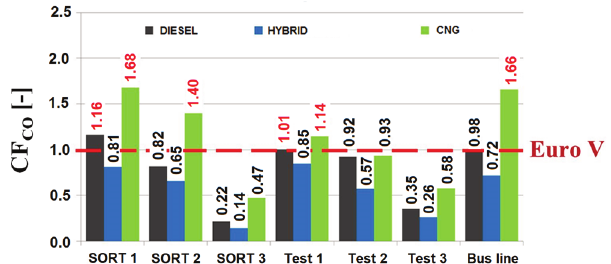
Fig. 29. Carbon monoxide emission conformity factor CF CO obtained from measurements in real operating conditions and the Euro V–EEV emission limits